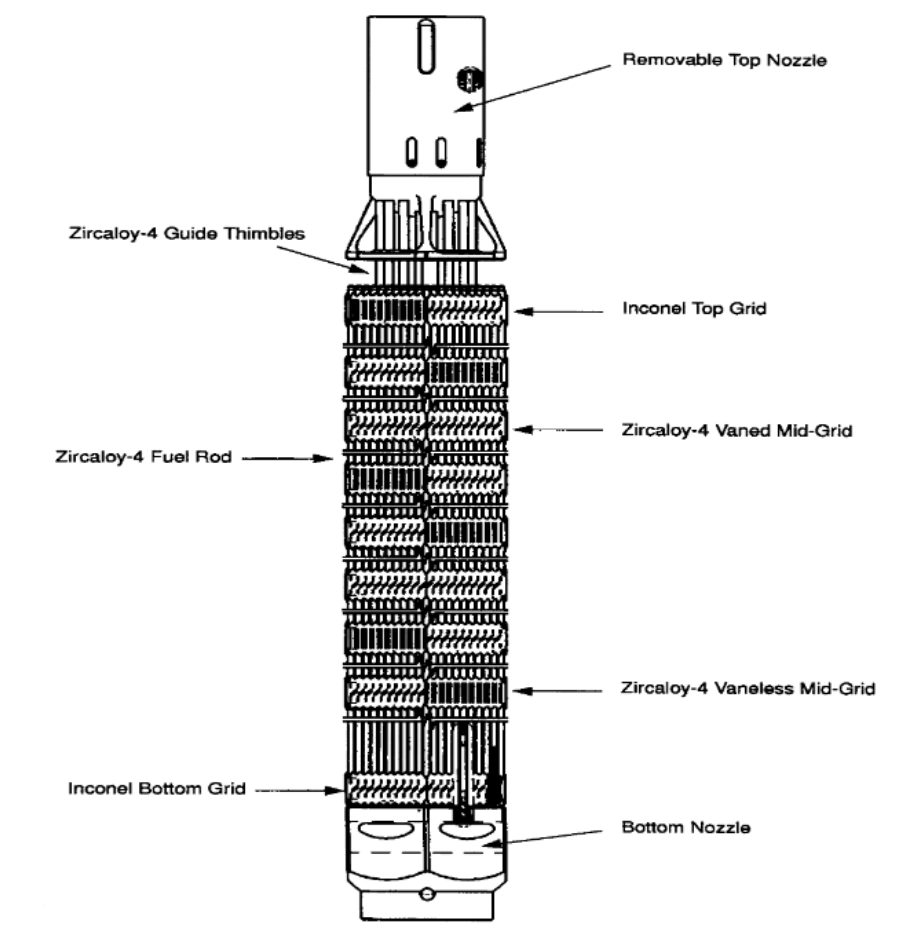
Figure 1. VVANTAGE-6 fuel assembly [11].